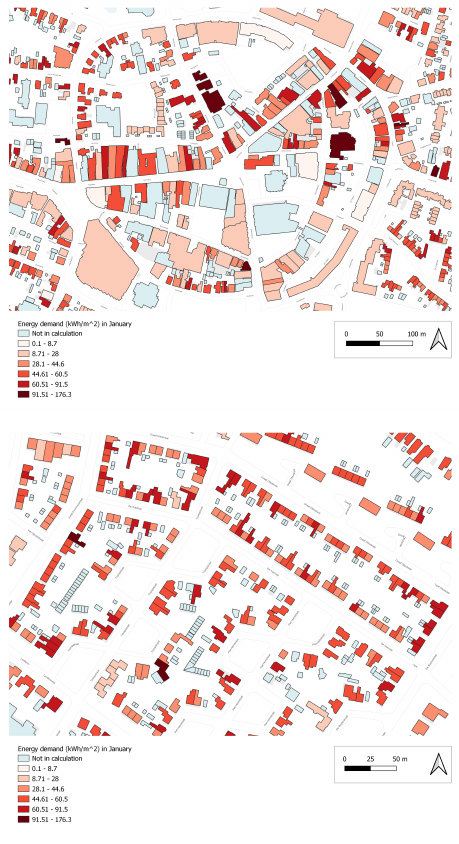
Figure 13. Energy demand (kWh) in the month January in the center (top) and a residential area (bottom) in Rijssen.